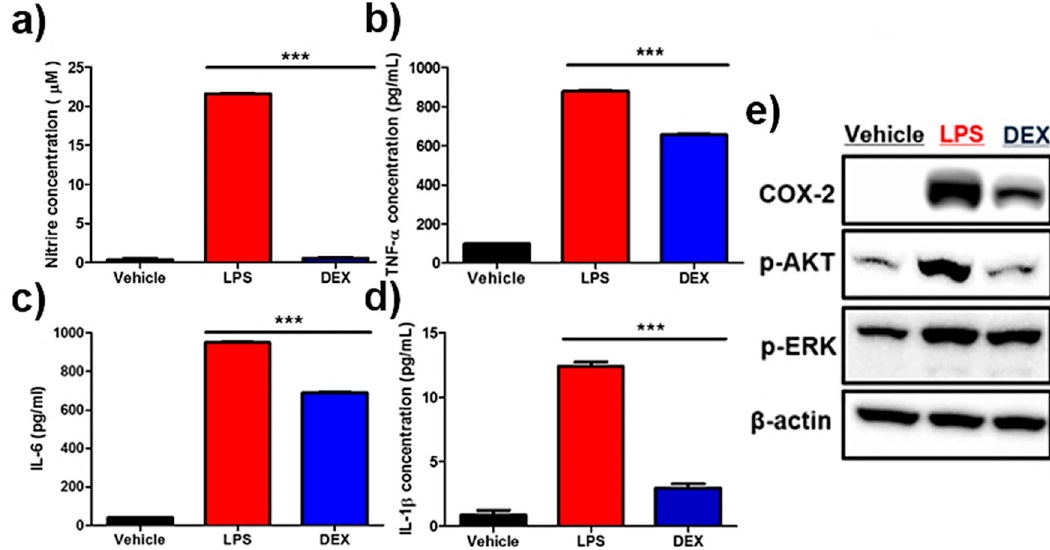
Figure 4. Effects of dexamethasone (DEX) on lipopolysaccharide (LPS)-stimulated reporter macrophages. Reporter macrophages were pre-treated with the indicated concentration of DEX for 1 h and then with LPS (1 μ g/mL, 24 h). ( a ) Nitric oxide (NO) levels in respective reporter macrophages. Expression levels of the cytokines ( b ) TNF- α , ( c ) IL-6, and ( d ) IL-1 β in the culture medium were determined by the enzyme-linked immunosorbent assay (ELISA). ( e ) Western blot analysis showing the expression levels of COX-2, p-AKT, and p-ERK in respective reporter macrophages. Values obtained from three individual experiment are expressed as the mean ± standard deviation (SD), *** p < 0.001